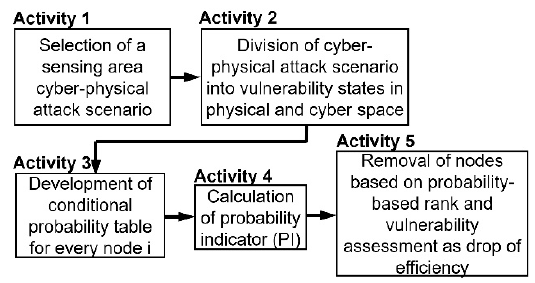
Figure 2. Process diagram of vulnerability assessment approach .